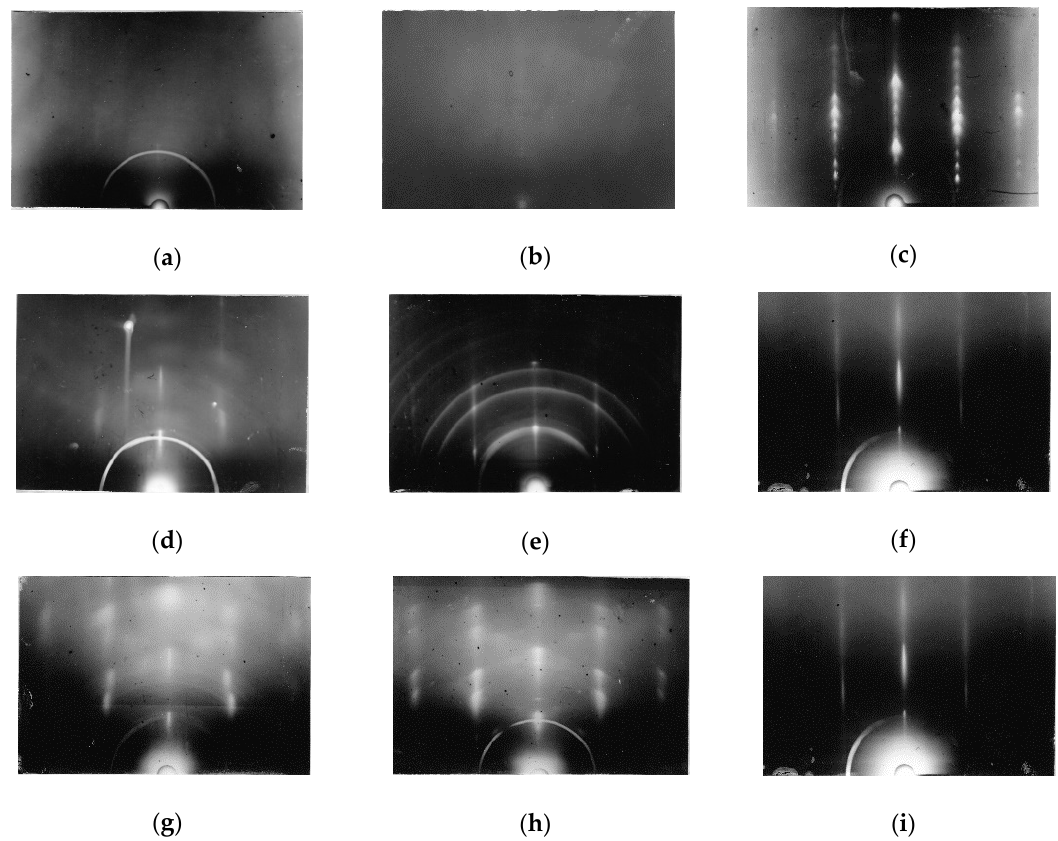
Figure 6. RHEED pattern evolution of C-face (0001 ) -oriented 15R-SiC implanted with 3 × 10 16 cm − 2 Ar + ions for growth times of 30 s ( a , b , c ), 45 s ( d , e , f ), and 120 s ( g , h , i ). RHEED patterns ( a , d , g ) are from the implanted part of the crystal without an epitaxial layer, whereas the RHEED patterns ( b , e , h ) are taken from the epitaxial layer grown on the implanted crystal surface. The RHEED patterns taken from the epitaxial layer grown on the non-implanted part of the crystal are shown in ( c , f , i ). Azimuth [11 2(cid:3364) 0].